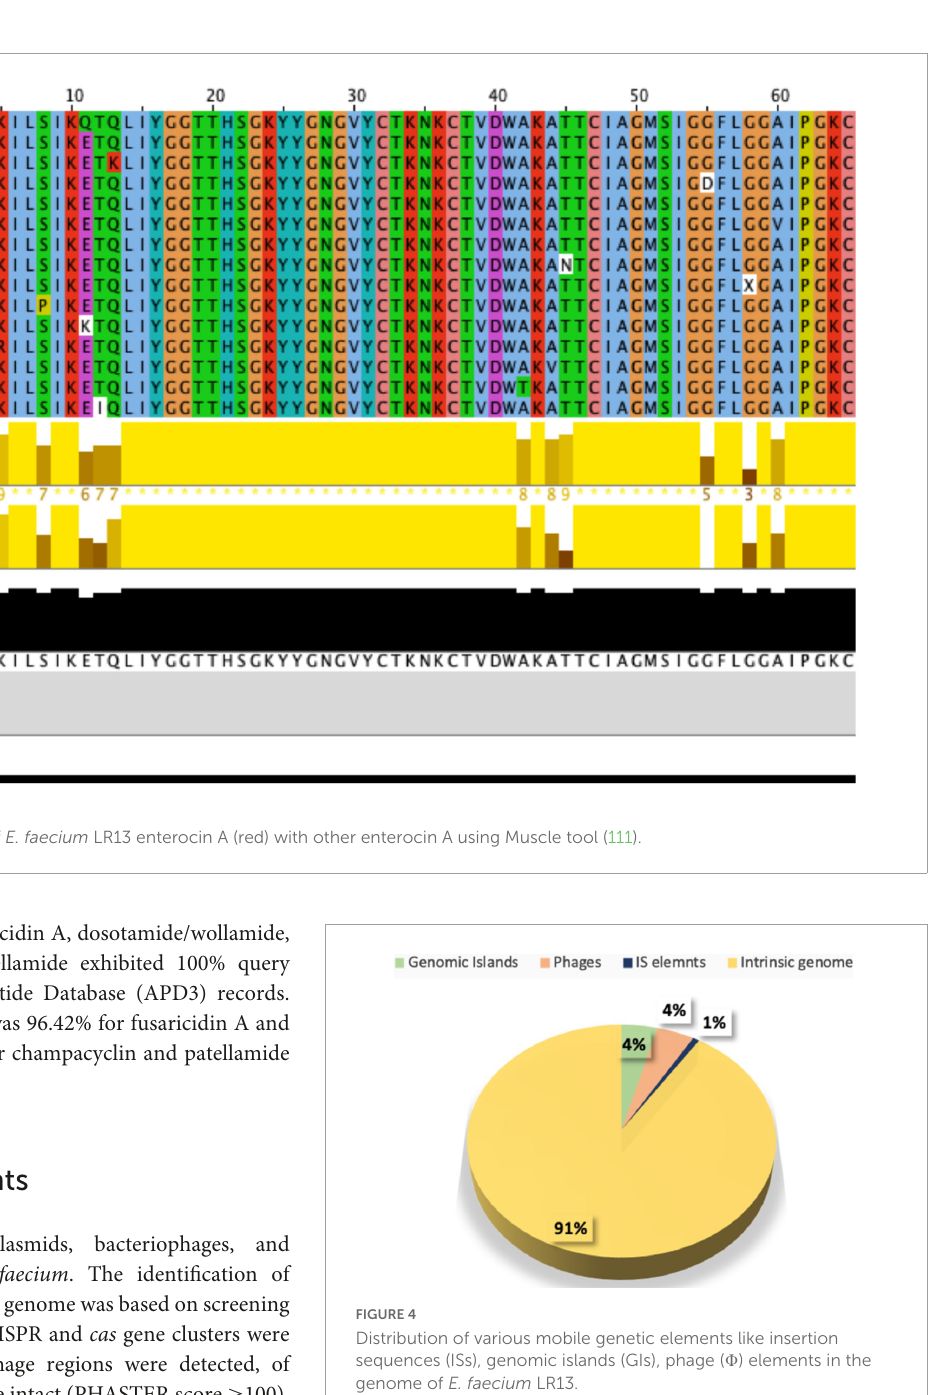
virulence or AMR genes were found on the GIs of LR13. The MGEs discerned in LR13 are depicted in Figure 4